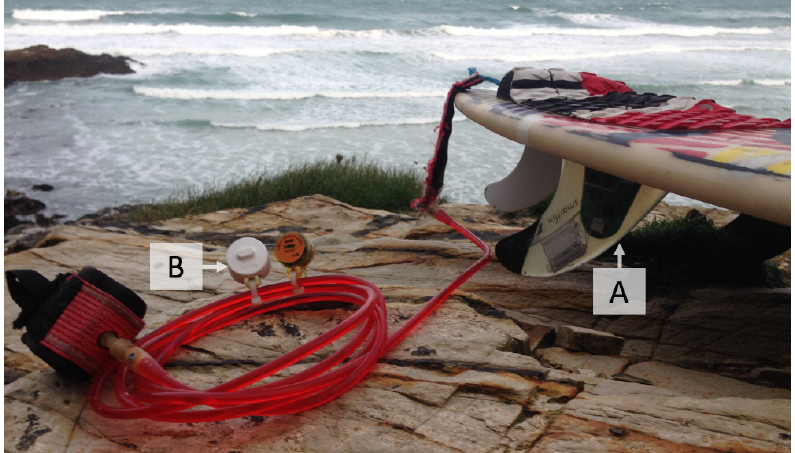
Figure 3. Image showing Smartfin ( A ) and TidbiT v2 temperature sensor with protective boot ( B